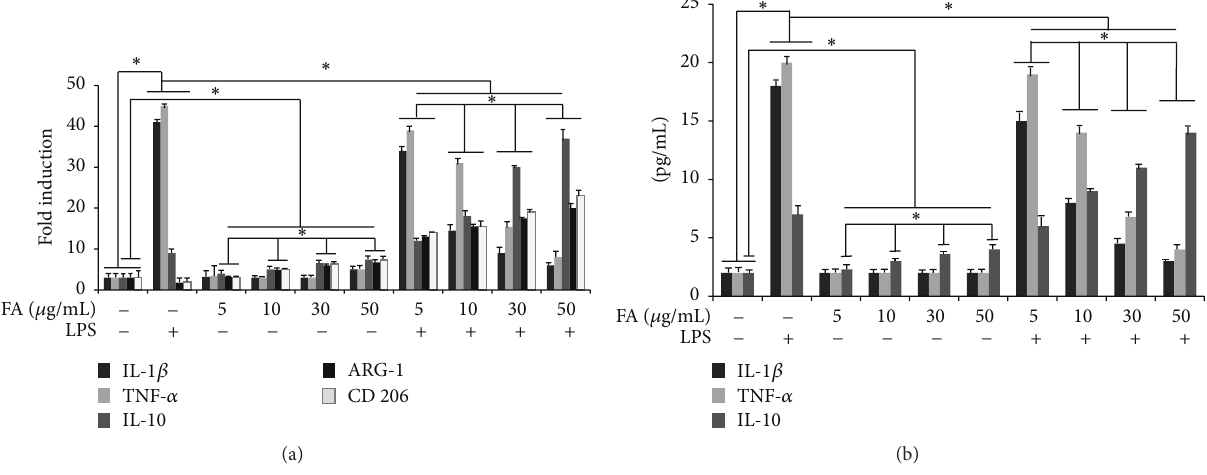
Figure 2: Effect of folic acid on cytokines production and microglia activation in LPS-stimulated BV-2 cells. (a) Proinflammatory cytokine and microglia activation markers mRNA expression determined by real-time RT-PCR. BV-2 microglial cells were incubated for 6h with LPS alone or after 1h of pretreatment with different amounts of folates. (b) ELISA assay. Cells were treated with the indicated doses of folic acid for 1h before LPS (1 𝜇 g/mL) treatment. Supernatants were collected at 24 h after LPS treatment and the amounts of IL1- 𝛽 , IL-10, and TNF- 𝛼 were measured. This assay was performed in triplicate and data are expressed as the mean ± SD of five independent experiments. ∗ 𝑝 < 0.05 .